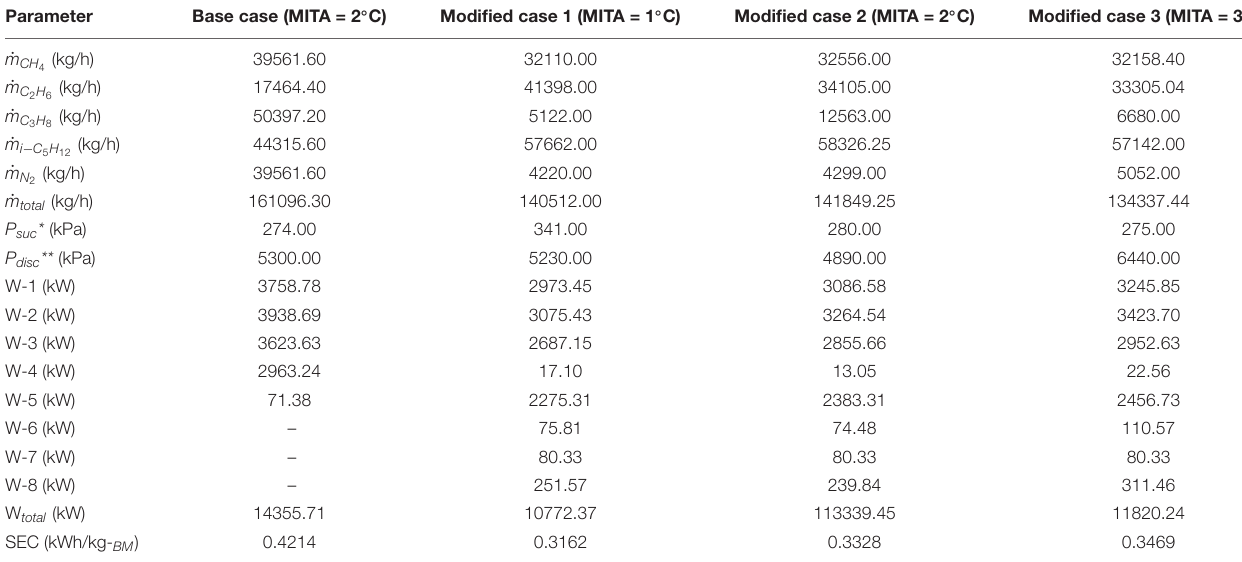
TABLE 4 | The decision parameters along with the power consumption after optimization.